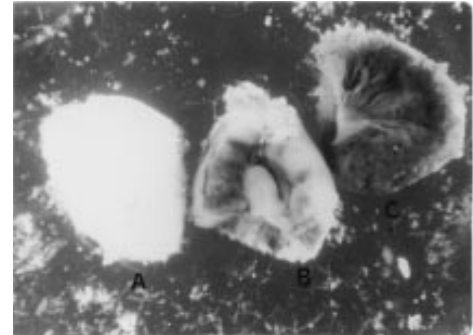
Figure 2 - Heterogeneously per- fused kidney slice from a norepi- nephrine-treated rat. A , Area with perfused glomeruli; B , area with ischemic